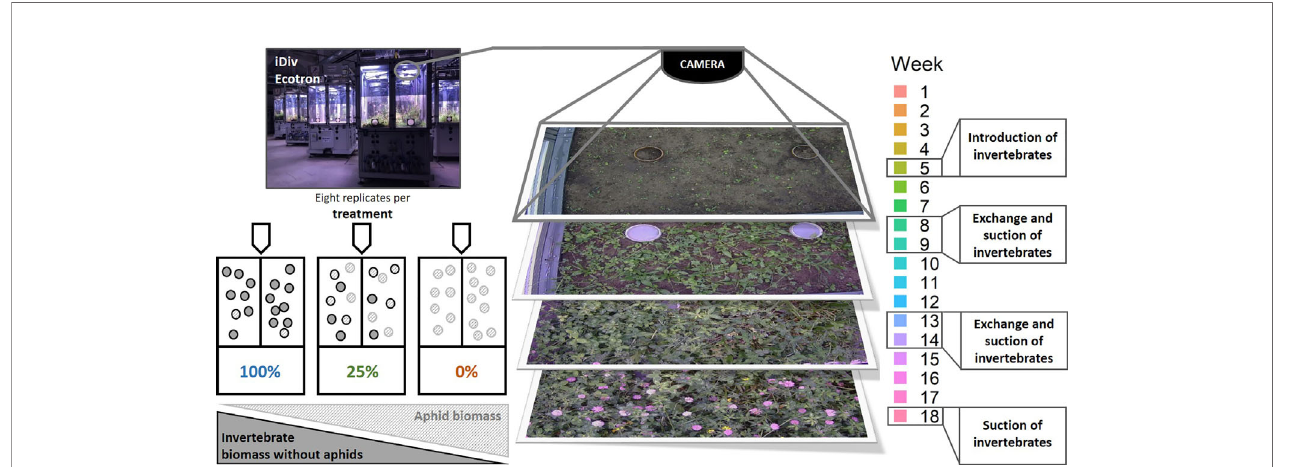
FIGURE 1 | Set up of the Ecotron experiment to assess the effect of a loss of invertebrate biomass on plant species composition and phenology of an experimental 12-species grassland community. The photo in the top-left corner shows the iDiv Ecotron (Eisenhauer and Türke, 2018). In each EcoUnit, cameras were installed which took daily pictures of the vegetation (middle). Different treatments were applied to simulate changes in invertebrate biomass (100%, 25%, and 0%) with eight replicates each (bottom left). A decrease in invertebrate biomass negatively correlated with aphid biomass (bottom left and Supplementary Figure 1 ). As indicated in the timeline (right), invertebrate introduction took place after 5 weeks, invertebrate exchange after 8 and 13 weeks. The last suction marked the end of our